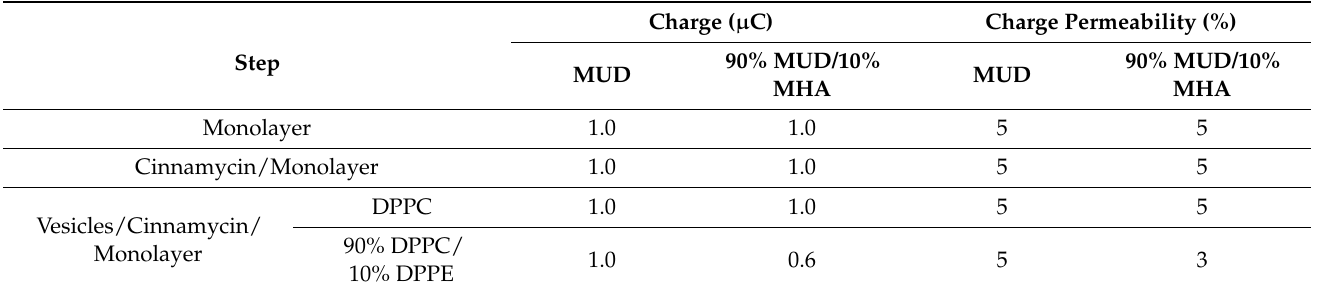
Table 1. Charge permeability with respect to each case treated on the gold electrode.